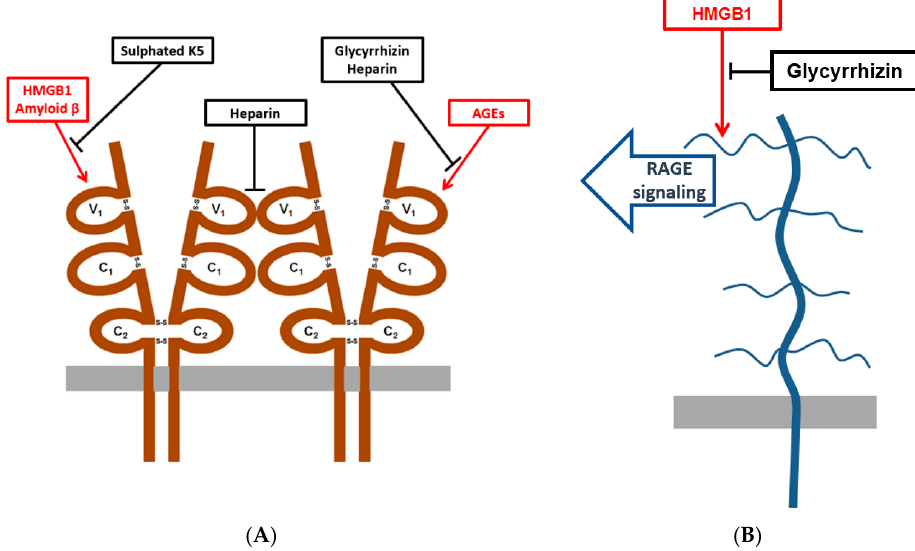
Figure 3. Schematic picture showing RAGE and HMGB1 antagonists used in this study. ( A ) A schematic picture showing RAGE extracellular V 1 -domain mediated interactions that were inhibited by glycyrrhizin, sulphated K5 oligosaccharides, and heparin in this study. ( B ) A schematic picture showing the predicted extracellular sulphated glycosaminoglycan binding of HMGB1 and inhibition of binding and RAGE signaling by glycyrrhizin.